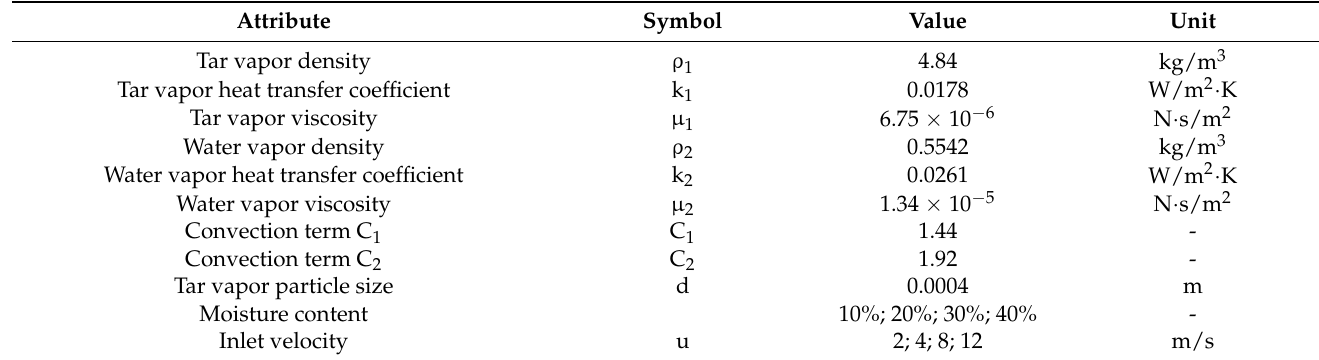
Table 2. The characteristic parameters of oil–water two-phase vapor.